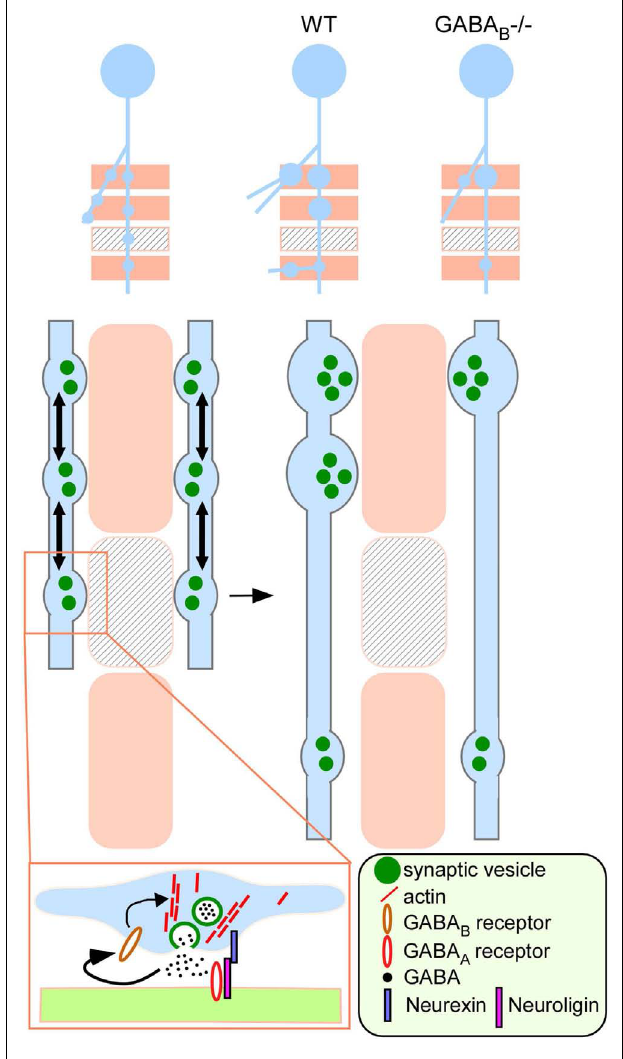
FIGURE 10 |A model on the role of presynaptic GABA B R in regulating the development of inhibitory synapses. A developing GABAergic axon (light blue) explores potential synaptic targets (beige rectangles) by making transient synaptic contacts. Beige rectangles represent appropriate targets; rectangles with lines represent inappropriate targets.These transient contacts contain release machinery, such as synaptic vesicles (green filled circles) that are mobile (arrows) along the axon and mediate GABA release (boxed inset). Autocrine GABA signaling through presynaptic GABA B R promotes actin polymerization likely through G protein signaling and stabilizes mobile synaptic vesicles at the developing terminal.Through synaptic activity and GABA B R dependent recruitment and redistribution of presynaptic resource (e.g., synaptic vesicles), contacts at the inappropriate targets are eliminated whereas those at the appropriate targets are validated and strengthened (WT). In the absence of GABA B R (GABA B R − / − ), nascent contacts fail to stabilize mobile synaptic vesicle pools according to GABA release, leading to reduced bouton density and aberrant distribution along axon